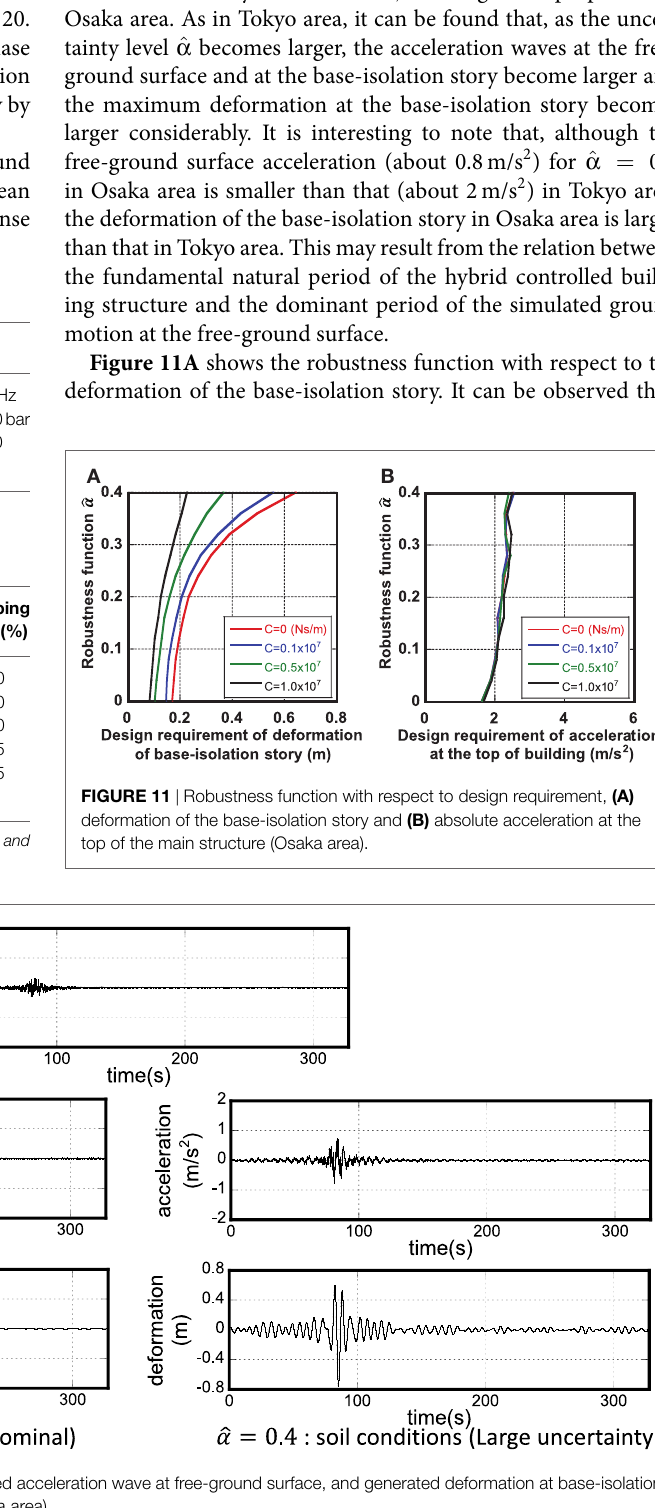
Frontiers in Built Environment |